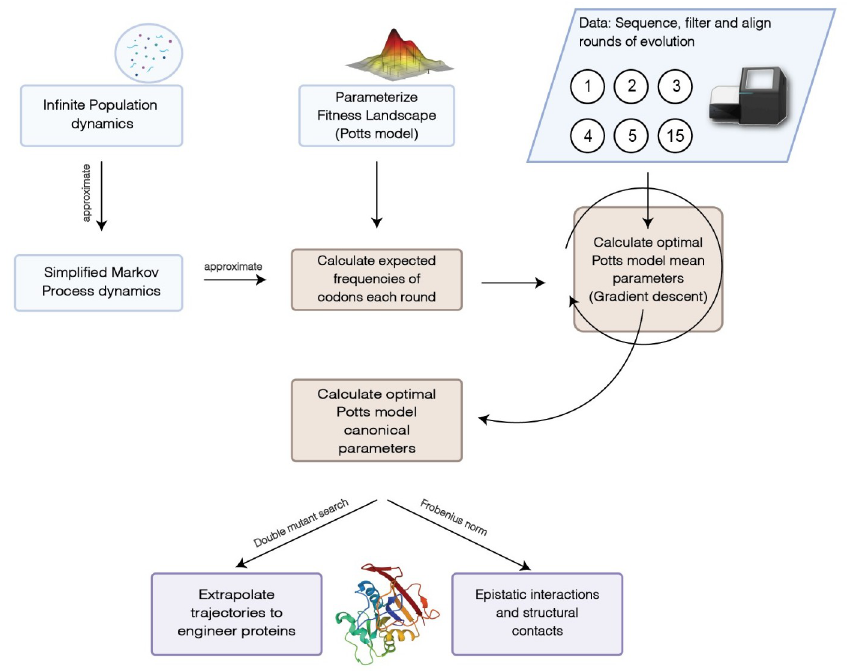
Fig 4. An overview of the algorithm to infer fitness landscape